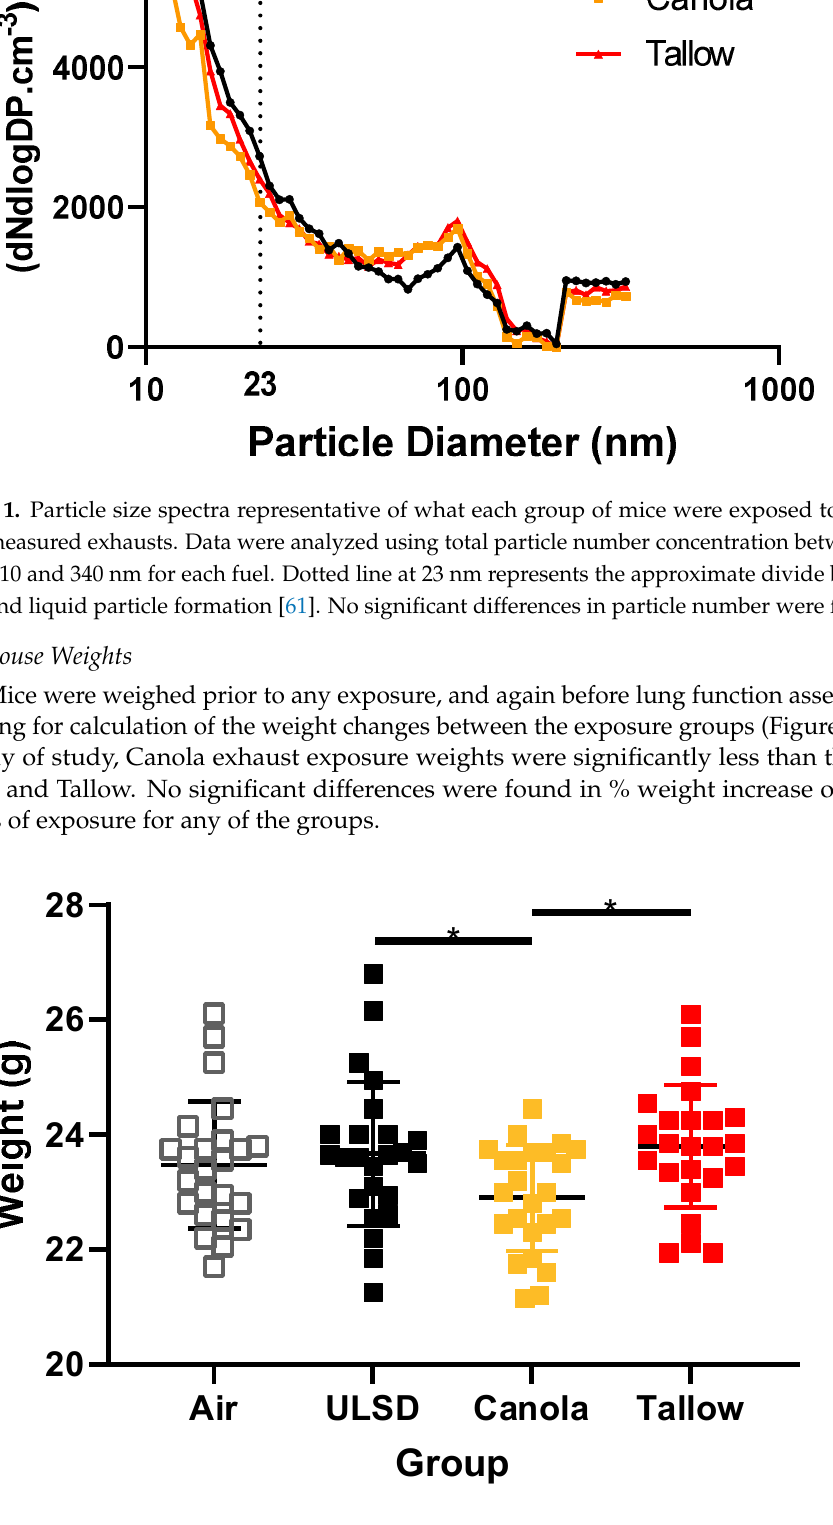
Figure 2. Mouse weights measured 24 h after the last exposure for each group (* indicates p < 0.05). n = 24 per treatment. Data were analyzed using general linear modeling methodologies.